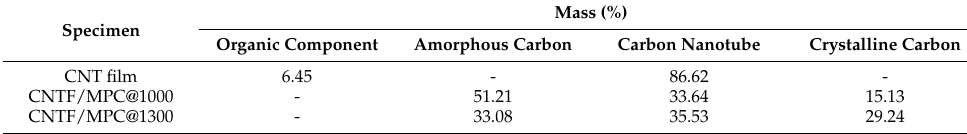
Figure 7. TEM images and the cross-sectional FIB-SEM images of the CNT film ( a , c ) and CNTF/MPC nanocomposites ( b , d ). Table 2. The mass percentage of different components of CNT film and CNTF/MPC nanocomposites.